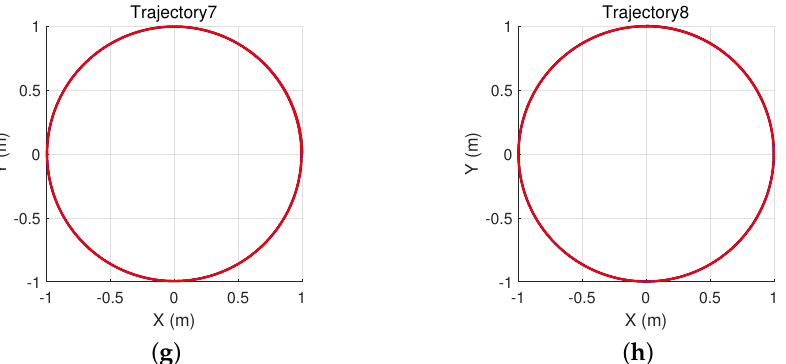
Figure 3. Collected simulation data. CW is clockwise and CCW is counterclockwise rotation. ( a ) Lin- ear Y = X . ( b ) Linear Y = − X . ( c , g ) circular (CCW). ( d , h ) circular (CW). ( e ) Clover (CCW). ( f ) Clover (CW).